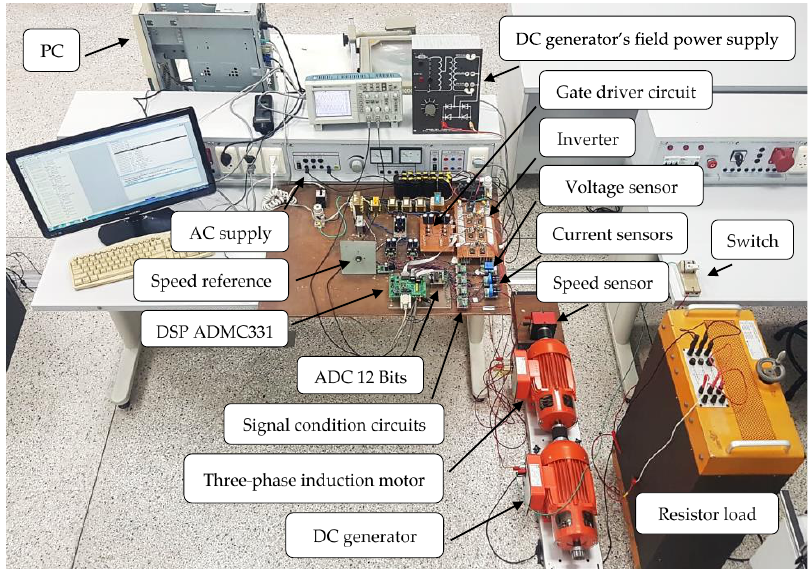
Figure 6. The experimental setup. PC: personal computer; AC: alternating current; ADC: analog to digital converter; DC: direct current.